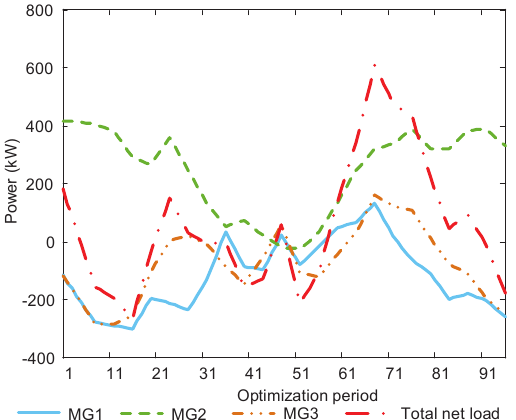
Figure 13. Net power curve of each MG and total net power curve of coalition on Day 2 of Scenario 1.